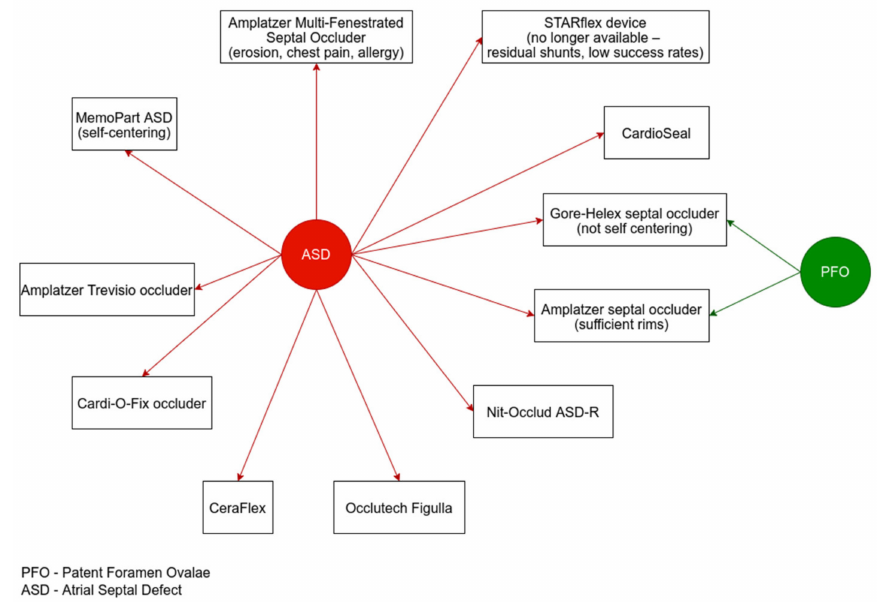
Figure 2. Routinely used devices in interatrial